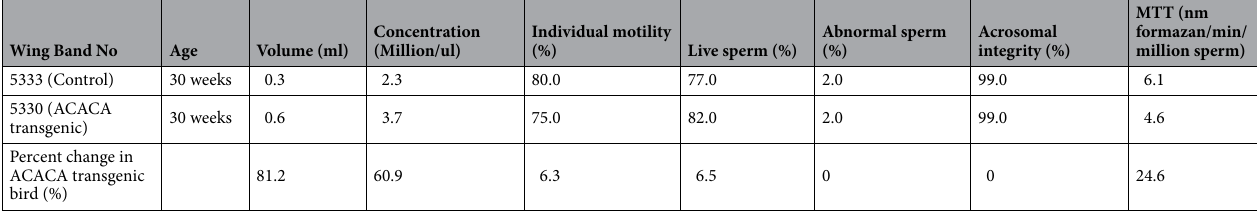
Table 13. Semen quality parameters in transgenic and control male birds. The semen quality was assessed in cocks at 30 weeks of age. Semen volume and sperm concentrations were higher in transgenic male than those in control male. MTT dye reduction by sperm was higher in control bird as compared to the transgenic bird indicating better fertilizing ability of sperms of control birds.